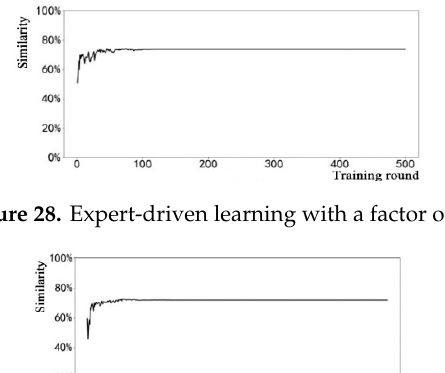
Figure 27. Expert-driven learning with a factor of 2/3.